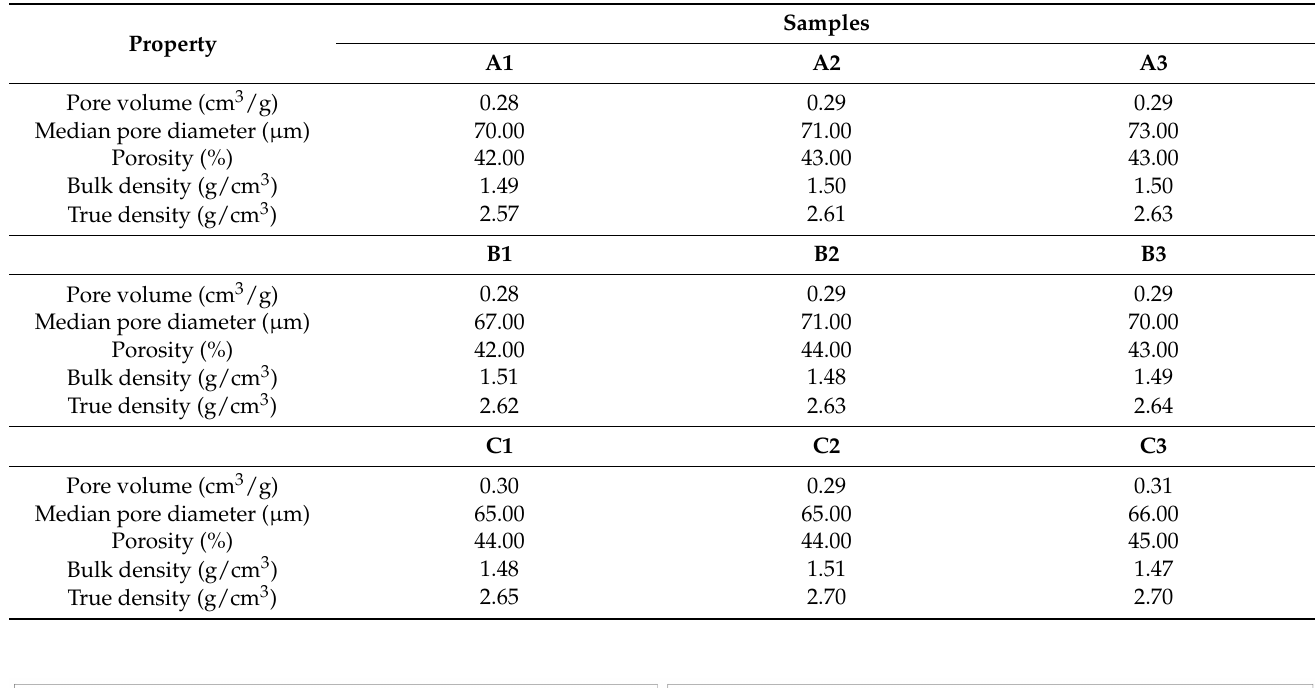
Table 4. Results of the mercury porosimetry measurements of the furan samples with varying grain size distributions for all the nine specimens.